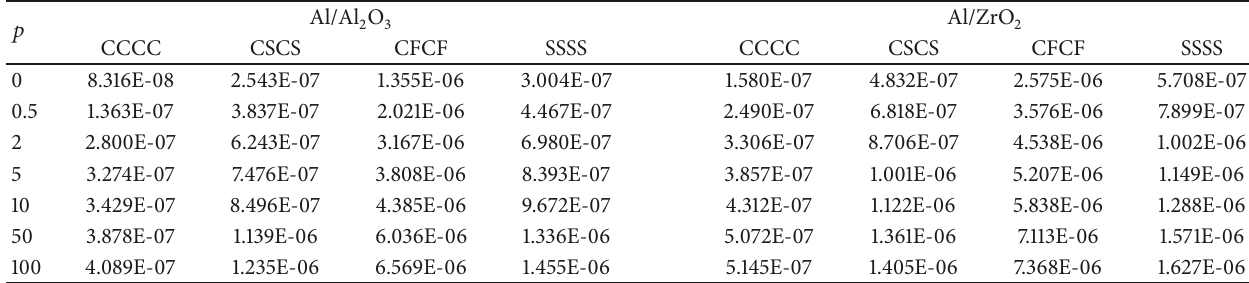
Table 6: Maximum deflection W for FG plates having various boundary conditions with the uniform pressure in the entire rectangular area. 𝑝